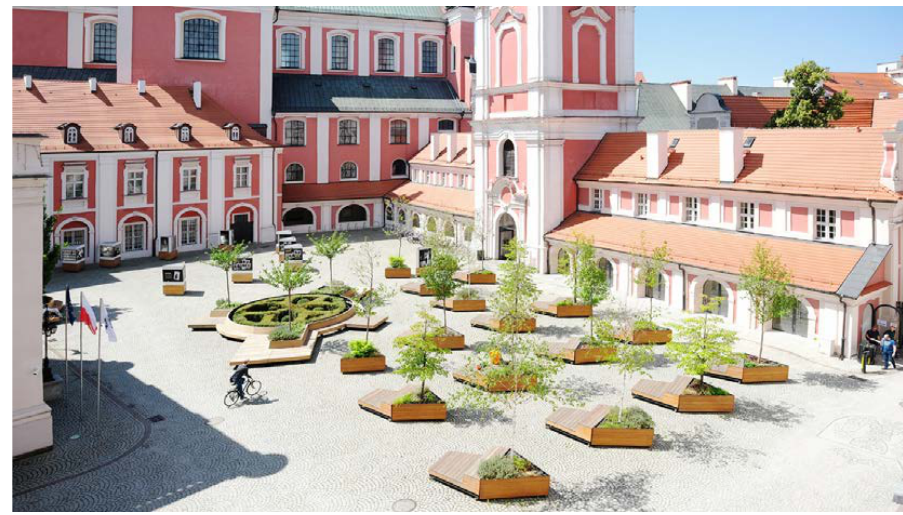
Figure 12. Courtyard City Hall, Poznan after completion in 2019 (Atelier Starzak Strebicki 2019).